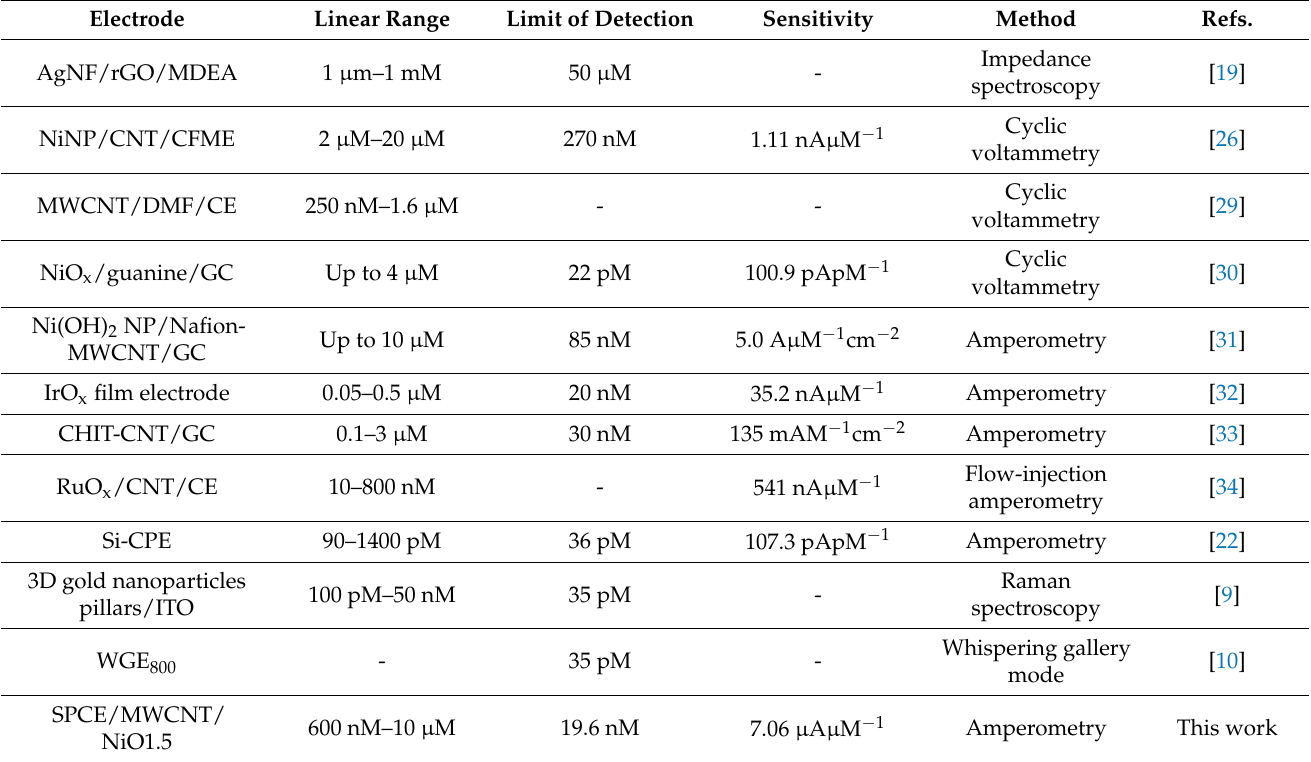
Table 1. Comparison of the sensing properties of different insulin determination methods from the literature with